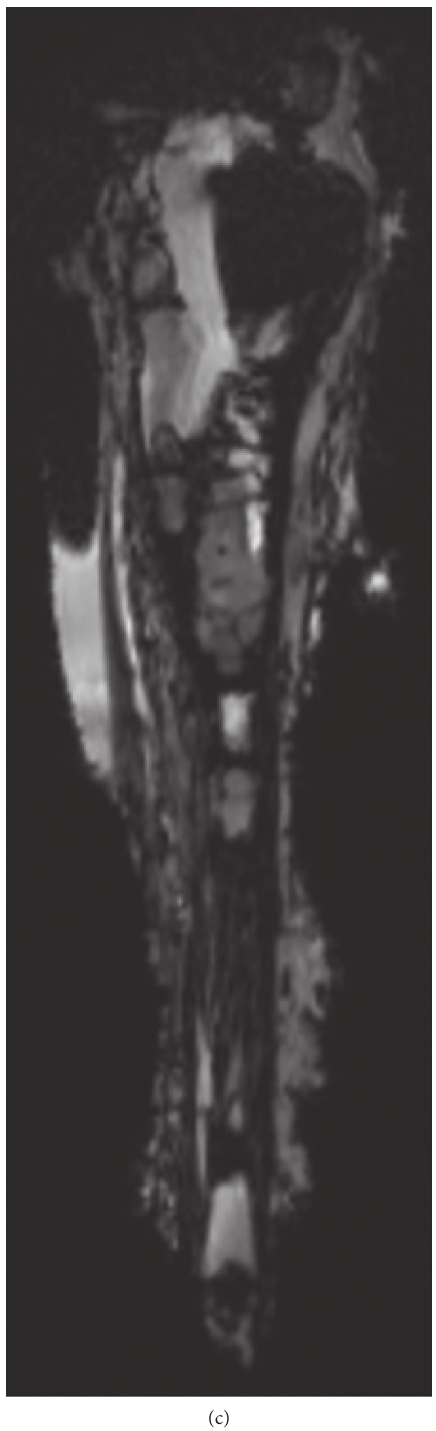
Figure 2: A 9-year-old girl with osteosarcoma of the distal radius. A step-cut was performed proximally for the stability of surgical reconstruction by using a PSI. Two margins were measured (medial and lateral part of the step-cut). Note the difficulty to visualize the cortical bone in the step-cut with MRI. (a) T1-weighted MRI; (b) macroscopic cut; (c) T2-weighted